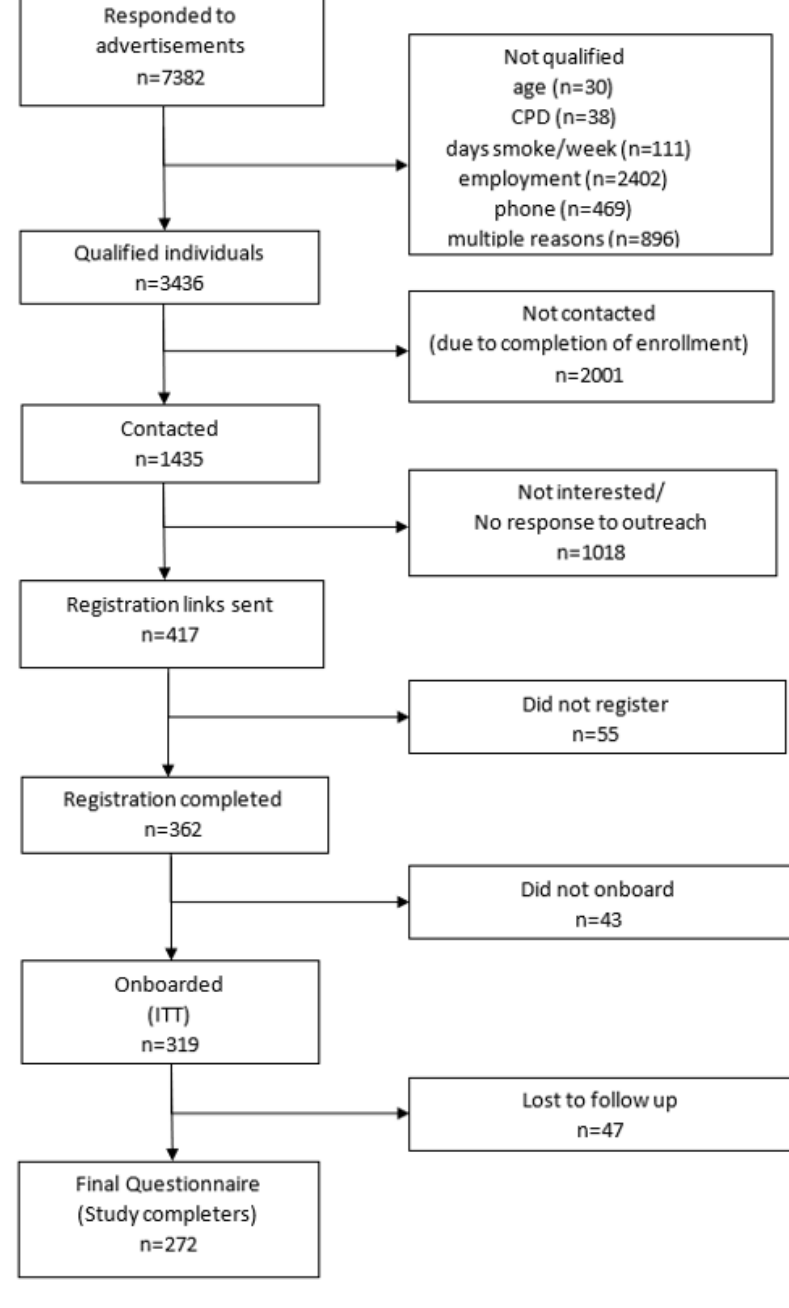
Figure 3. Consolidated Standards of Reporting Trials flow diagram of